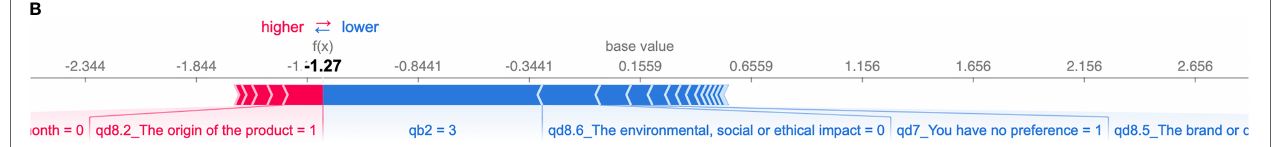
FIGURE 4 | Local interpretation examples. Force plots for two companies (A, B)